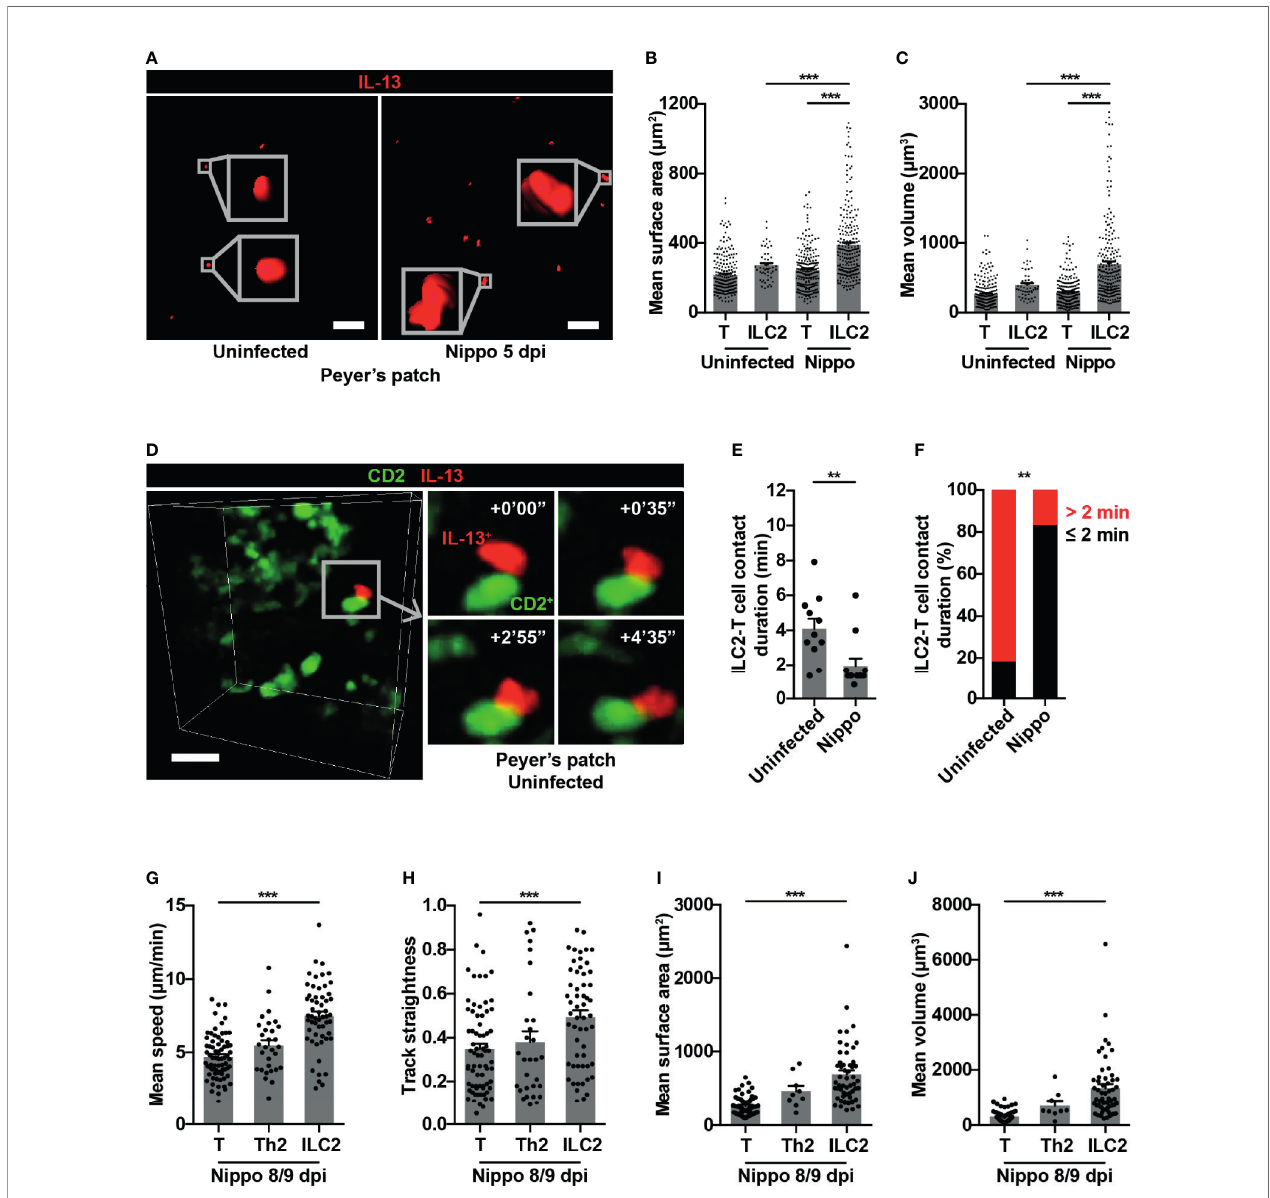
FIGURE 3 | PP ILC2s show changes in size and cellular interactions following helminth infection. (A) Examples of cell size of PP ILC2s, uninfected and 5 dpi; scale bar 50 µm, Z 48 µm. (B, C) Quanti fi cation of (B) mean surface area and (C) mean volume of T cells and ILC2s, uninfected and 5 dpi; *** p < 0.001. Pooled data from 6-9 movies from 3 mice per condition, each dot representing one cell track. (D) Intravital example of ILC2-T cell interaction in uninfected PP; scale bar 20 µm, Z 48 µm. (E) Quanti fi cation of ILC2-T cell contact duration (min), each dot representing one interaction; ** p < 0.01. (F) Quanti fi cation of proportions of ILC2-T cell contacts > 2 or ≤ 2 minutes; ** p < 0.01 by Fisher ’ s test. Pooled data from 6-7 movies from 3 mice per condition. (G – J) Quanti fi cation of (G) mean speed, (H) track straightness, (I) mean surface area and (J) mean volume of CD2 + T cells, CD2 + IL-13 + Th2 cells and IL-13 + ILC2s, 8/9 dpi; *** p < 0.001 ILC2 vs T. Pooled data from 3 movies, each dot representing one cell